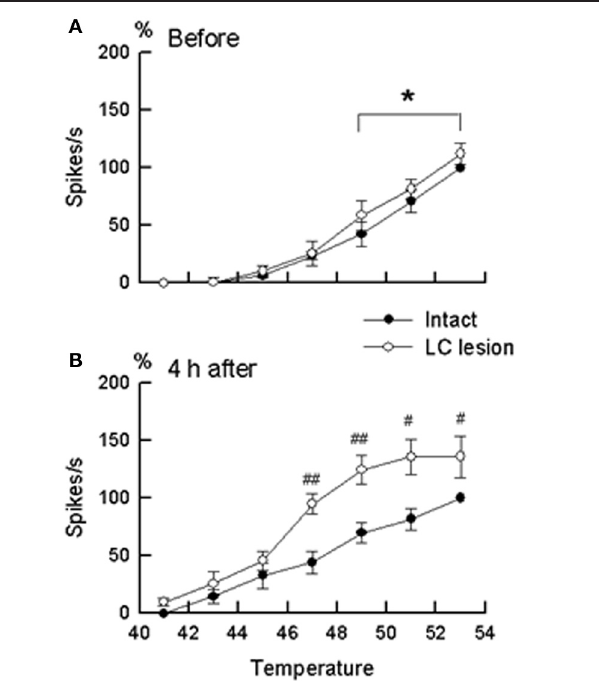
FIGURE 5 | The stimulus–response relationship in wide-dynamic-range neurons located in the dorsal horn ipsilateral to the site of inflammation. (A) Stimulus–response relationship before the induction of inflammation. (B) Stimulus–response relationship at 4h after the induction of inflammation. Closed circles ( ◦ ) represent neurons in the LC/SC-intact rats ( n = 11). Open circles ( • ) represent neurons in the LC/SC-lesioned rats ( n = 20). Neuronal discharges to each temperature in graded heat stimuli (ordinate) are expressed as a percentage of the control. In (A) and (B) , 100% (control) were discharges to heating at 53 ◦ C in the LC/SC-intact rats. # P < 0 . 05, ## P < 0 . 01, significantly different from the value of the LC/SC-intact rats (ANOVA, with Scheffe’s t-test as a post hoc analysis of differences). ∗ P < 0 . 05, significantly different between responses to heating at 49 ◦ C and responses to heating at 53 ◦ C (ANOVA, with Scheffe’s t-test as a post hoc analysis of differences). (Tsuruoka et al.,